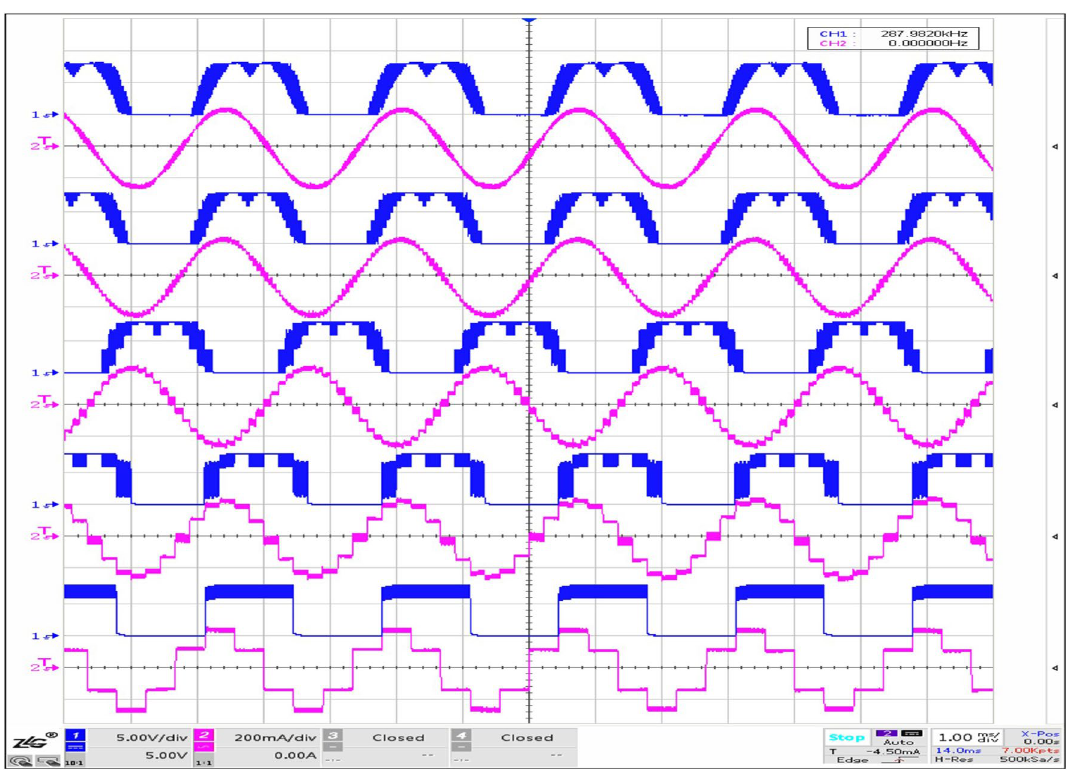
Figure 12. Experiment results of subdivision: from top to bottom displays the I s (red) and V a (blue) varying from subdivision 96 to 6 in